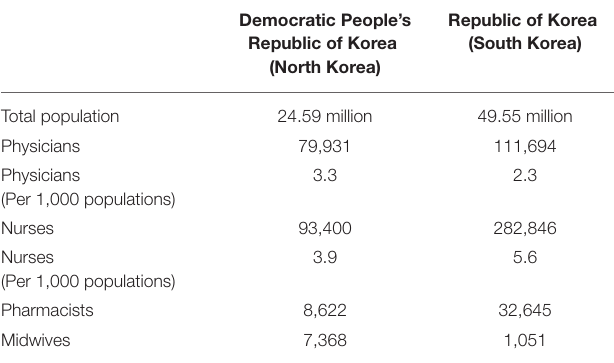
TABLE 1 | Comparison of the numbers of healthcare professionals between the Democratic People’s Republic of Korea (North Korea) and the Republic of Korea (South Korea).